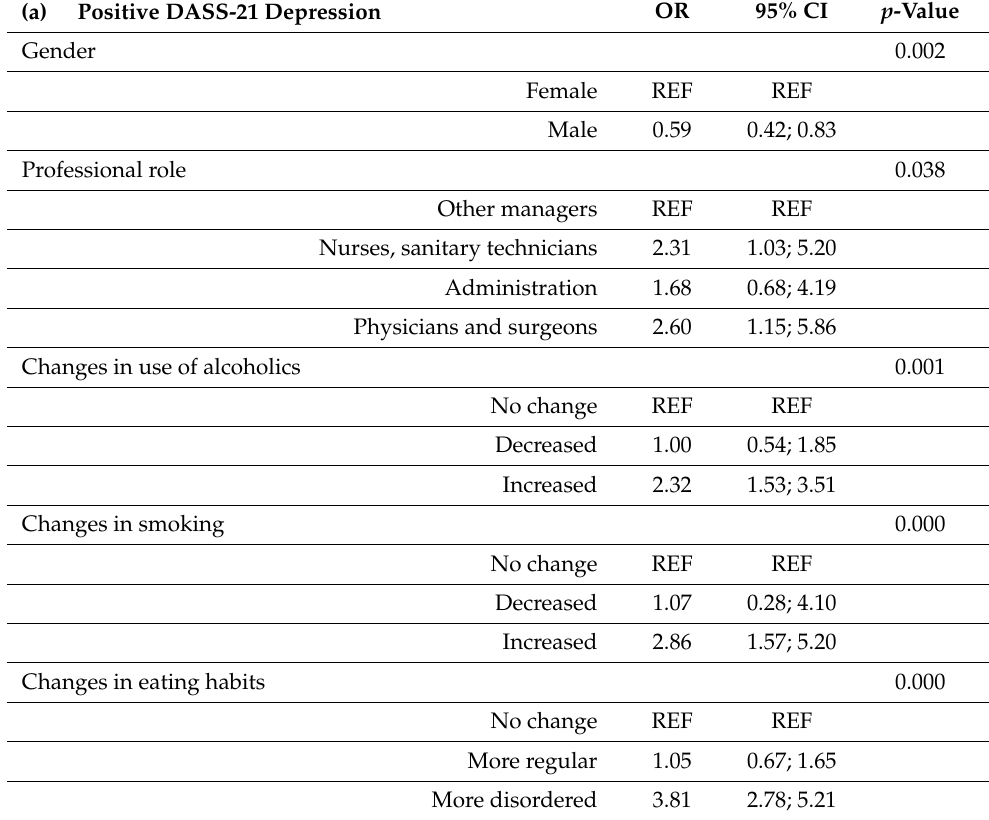
Table 2. Statistically significant associations with the psychometric results (univariate regressions).